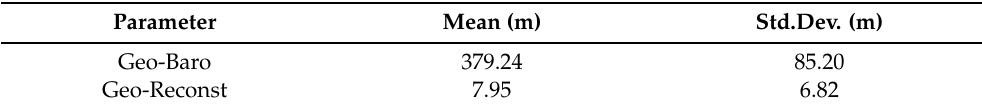
Table 2. Gaussian Parameters of Error Distributions in Figure